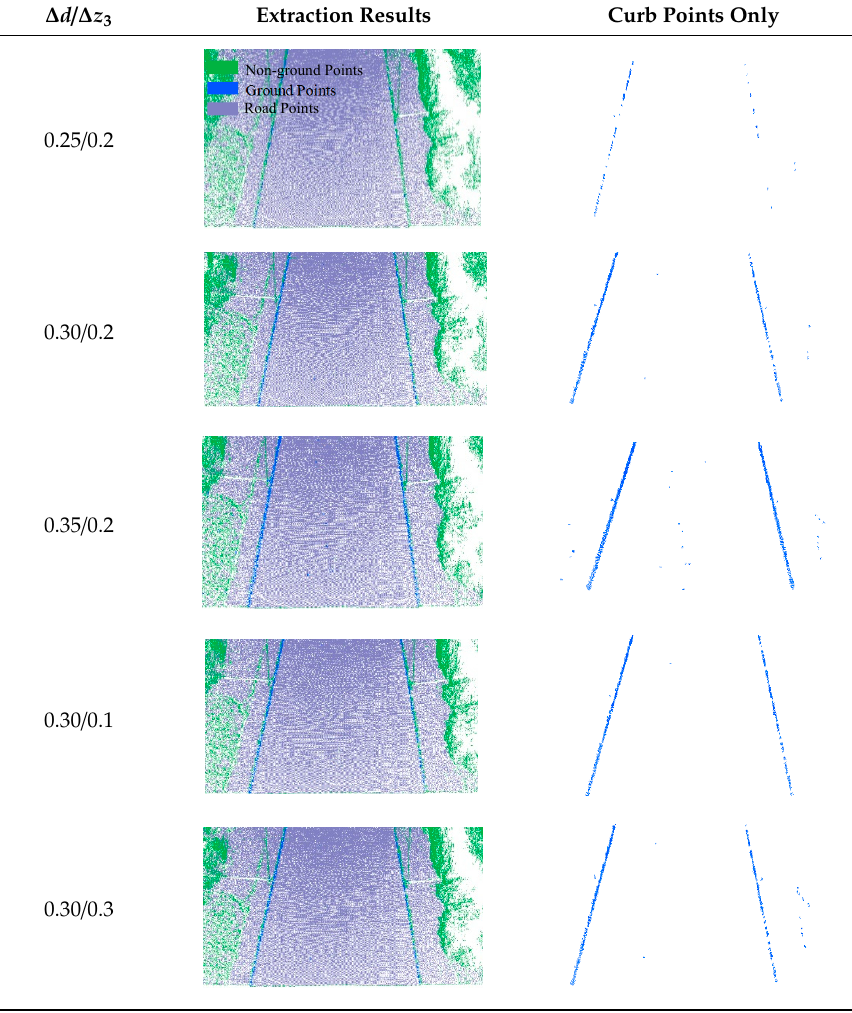
Table 3. Relationship between the extraction result and thresholds for curb points.